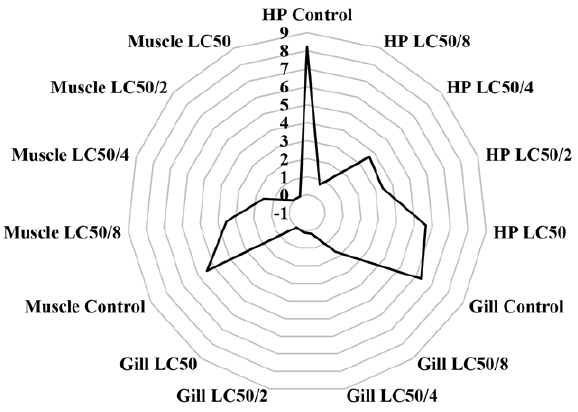
Figure 1. IBR analysis of biomarkers in the hepatopancreas, gill, and